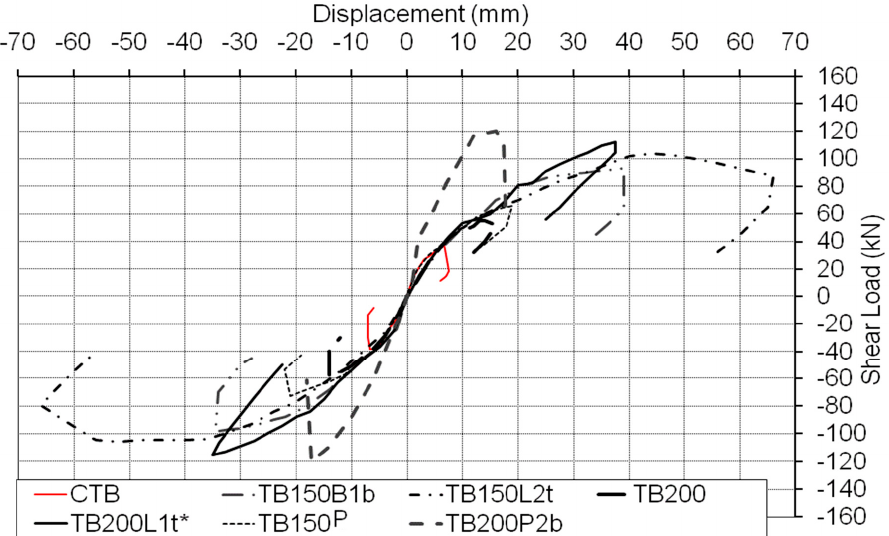
Figure 5. Load–deflection envelope curves.